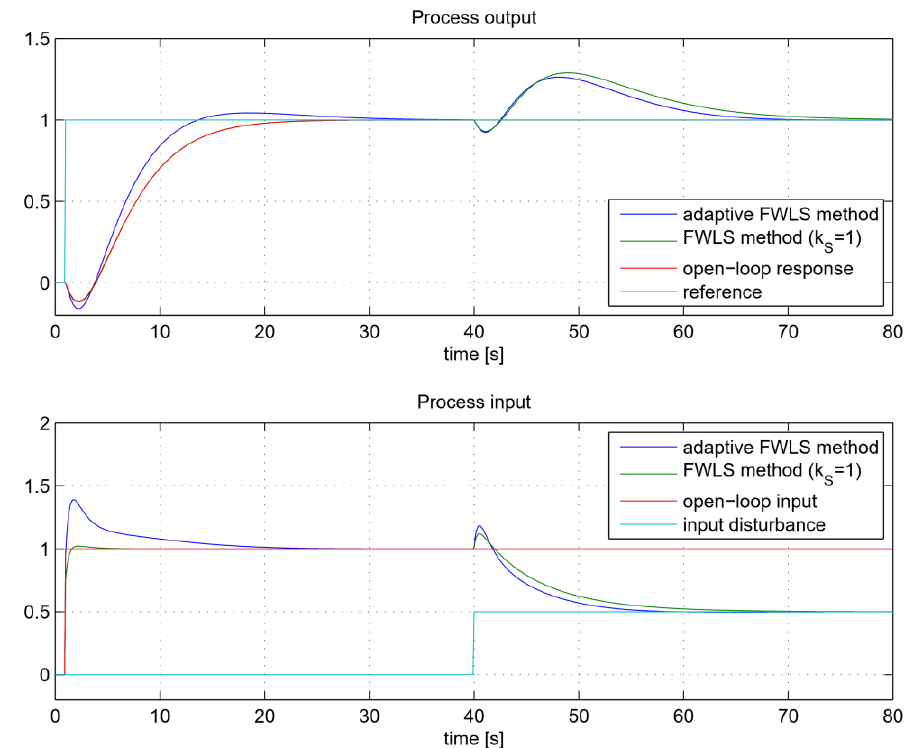
Figure 19. The closed-loop tracking and control signals for process G P 3 .